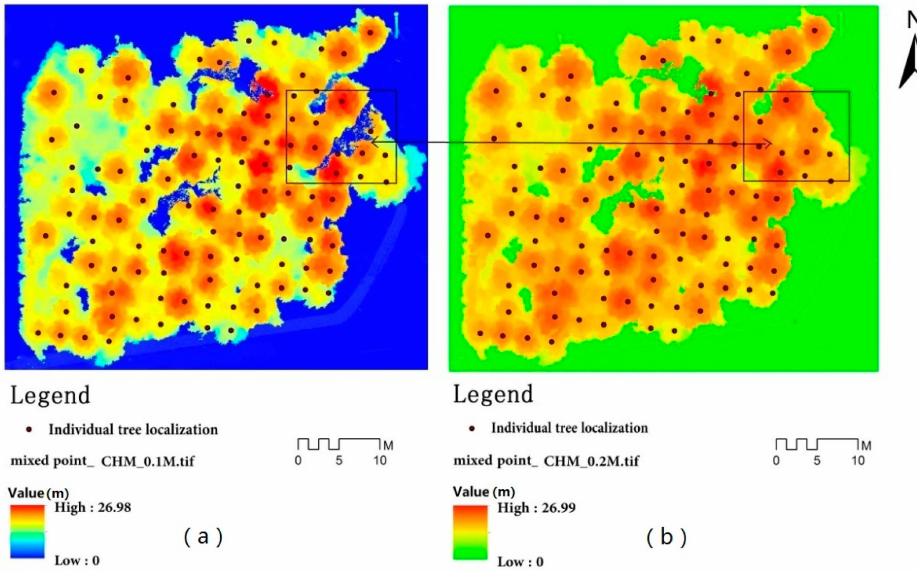
Figure 8. The ITL point in the CHM of the sample (( a ) the resolution of CHM is 0.1 m, ( b ) the resolution of CHM is 0.2 m, and the black box shows the di ff erence between the two CHM resolutions).